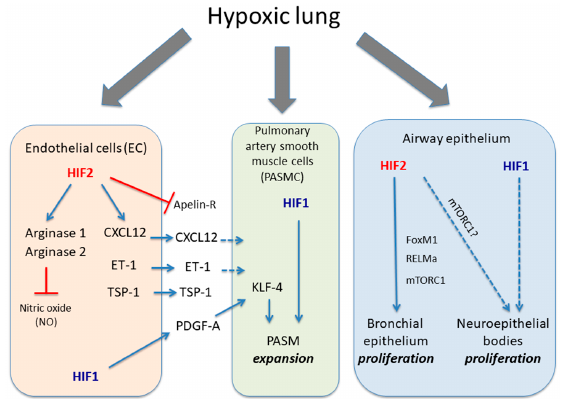
Figure 1. Role of HIF1 α and HIF2 α isoforms in different lung cell types in response to hypoxia. The figure shows the biological actions executed of HIF1 α and HIF2 α isoforms in endothelial cells, PASMC and airway epithelium in response to hypoxia. Endothelial HIF2 induces a series of responses leading to vasoconstriction such as induction of arginase activity, which limit endothelial NO availability as well as release CXCL12, ET-1 and TSP1 in parallel with an inhibition of apelin receptor. HIF1 activity in endothelial cells can also release PDGF-B, which cooperates through KLF4 with PASMC HIF1 activity to promote their expansion. The figure also shows HIF2 activity in bronchial epithelial proliferation through potential mediators such as mTORC1, RELM α or FOXM1 as well as the potential role of HIF1 α in neuroepithelial bodies proliferation located in pulmonary epithelium. Solid dark blue lines indicate activatory pathways; dashed dark blue lines indicate potential activatory actions and red lines indicate inhibitory